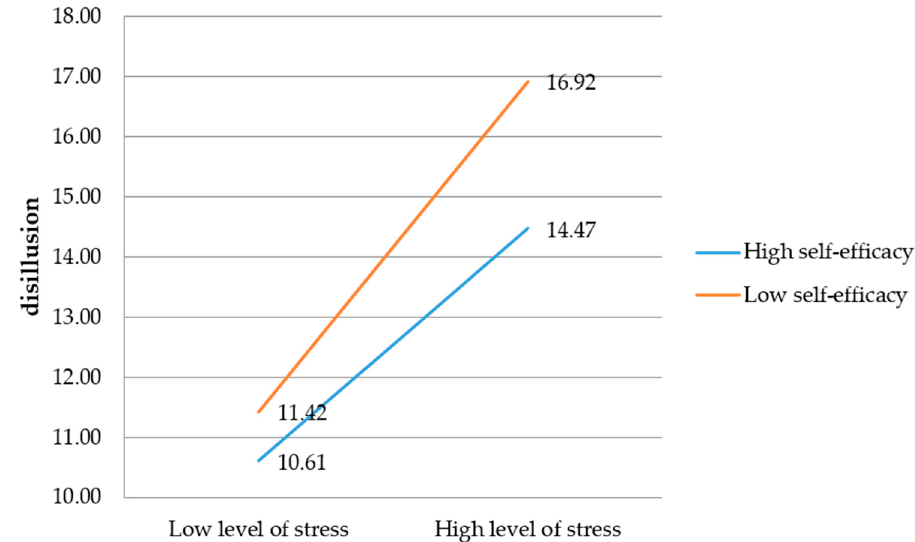
Figure 7. The impact of the sense of self-efficacy on the relationship between the level of perceived stress and disillusion.